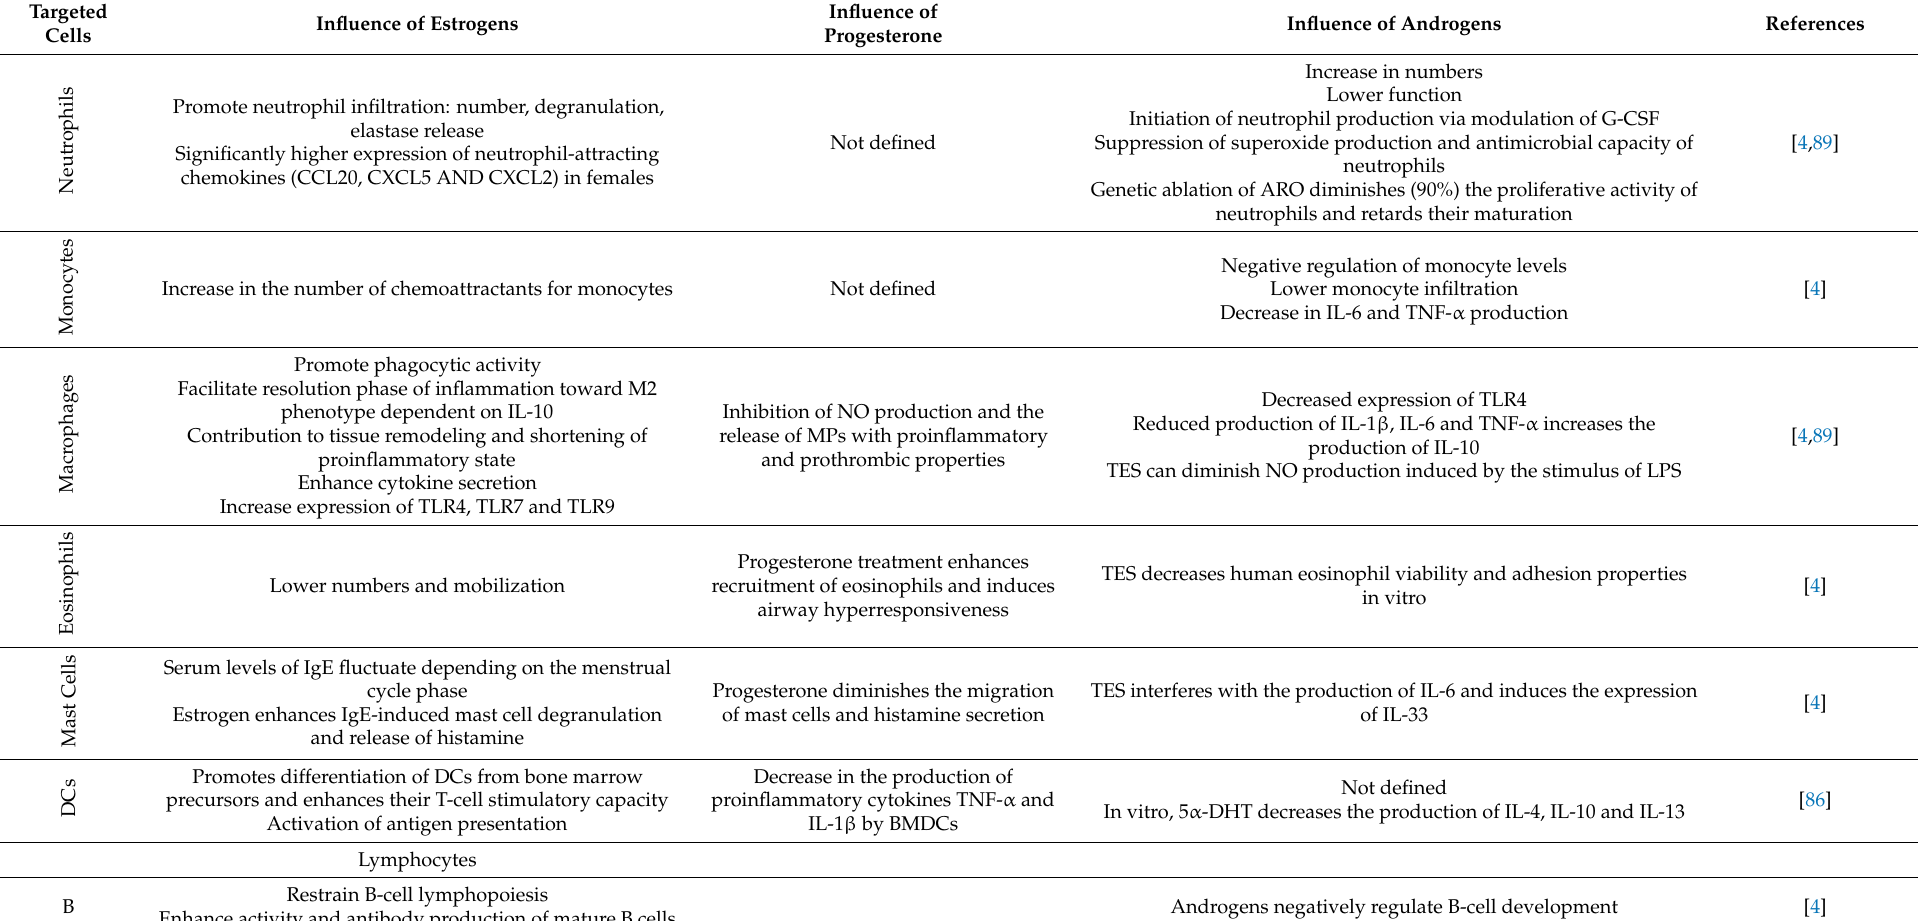
Table 1. Impact of sex hormones on elements of immunity: cells and